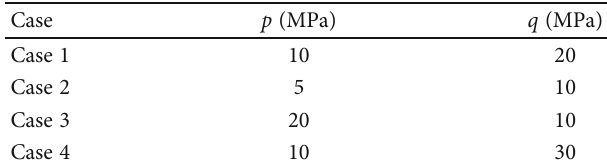
Figure 2: The mesh of the computational model. Table 1: Four kinds of crustal stress